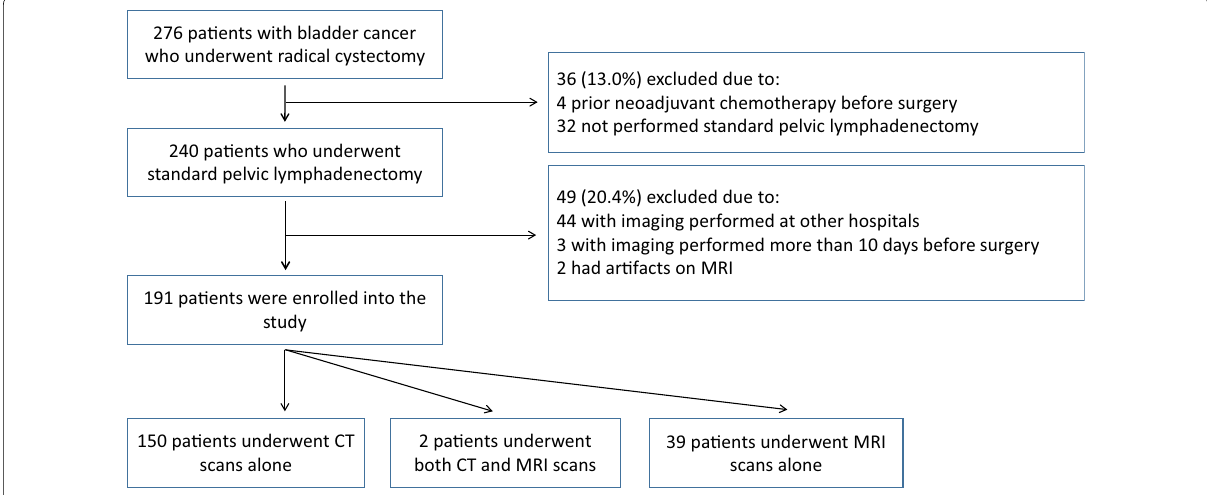
Fig. 1 Flowchart of selecting patients with bladder